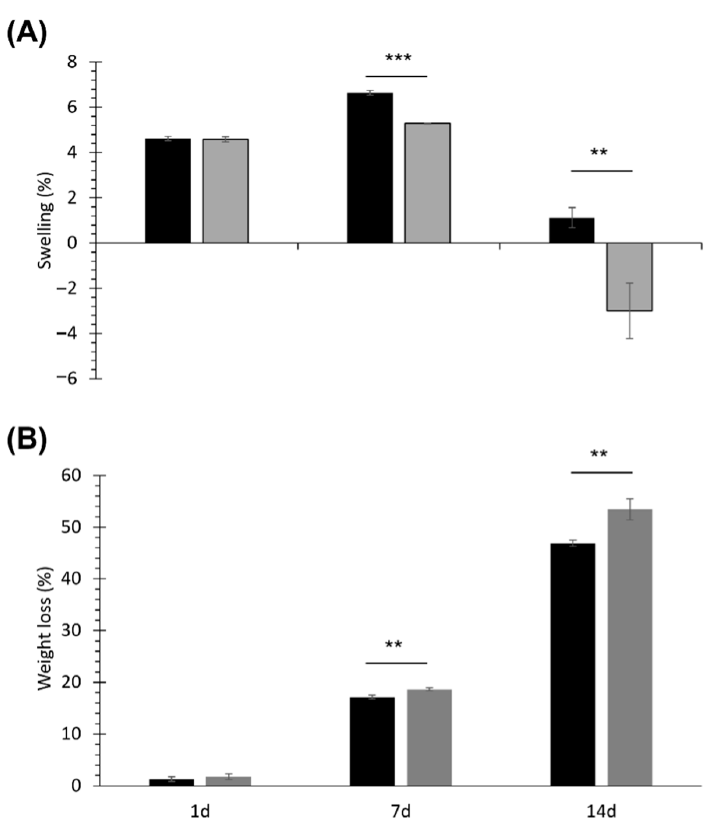
Figure 4. Percentage of swelling ( A ) and dried weight loss ( B ) for SHP (black bars) and SHP_MBG_Sr gels (grey bars). Significant results: p = 0.0001 (***) and p = 0.0055 (**) for swelling results on day 7 and 14, respectively; p = 0.0054 (**) and 0.0064 (**) for weight loss results on day 7 and 14, respectively.